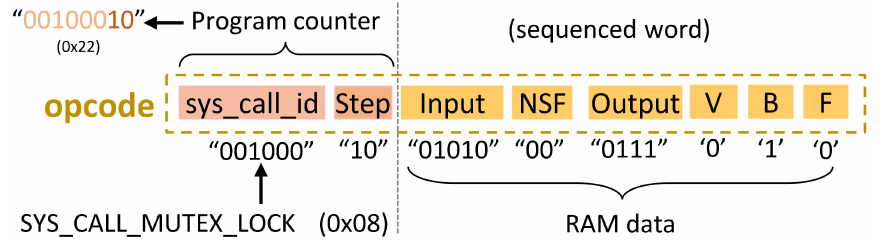
Figure 5. Microprogram-opcode format example in HW Mutex lock, Step2.